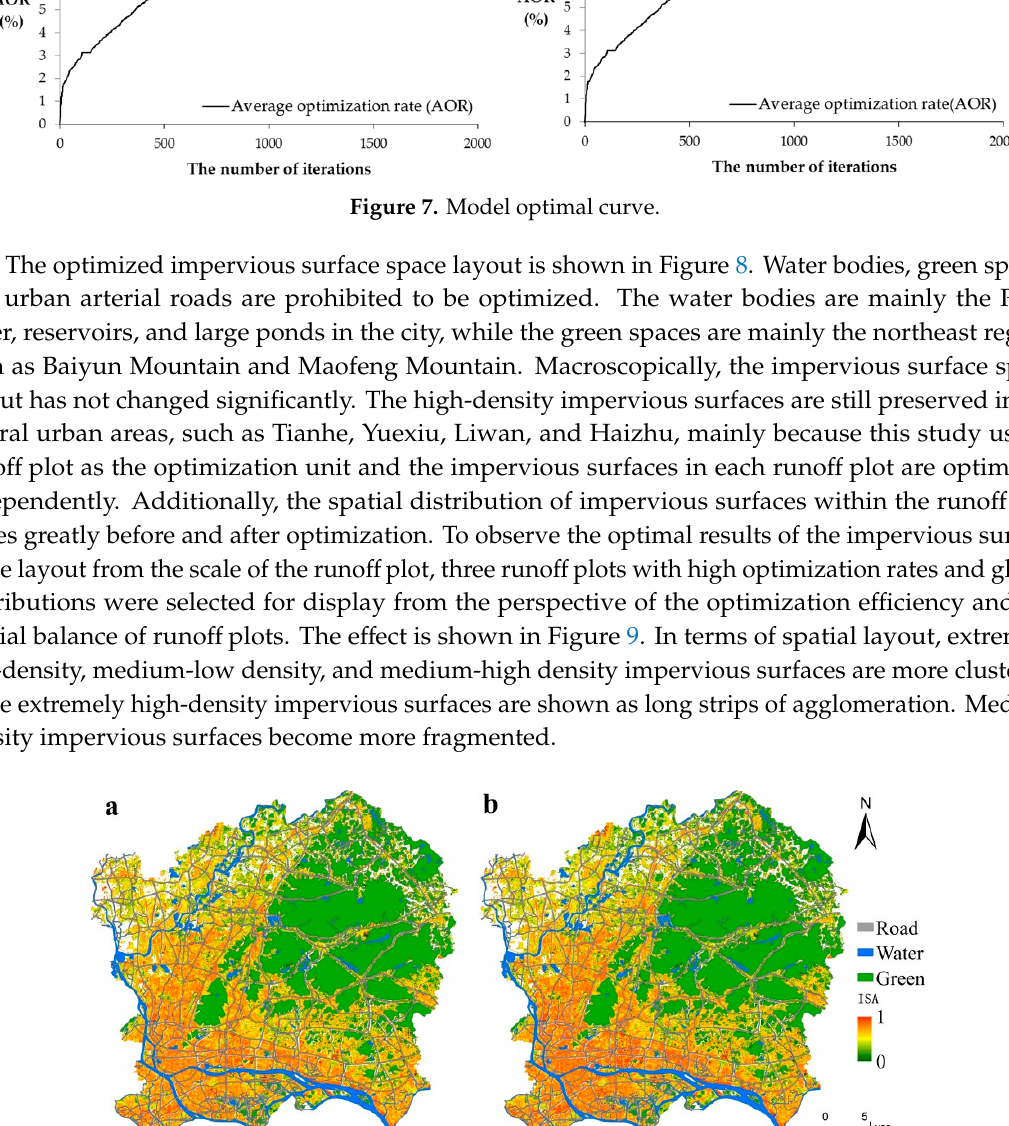
Figure 8. Impervious surface spatial distribution before and after optimization: ( a ) impervious surface spatial distribution before optimization and ( b ) impervious surface spatial distribution after optimization.